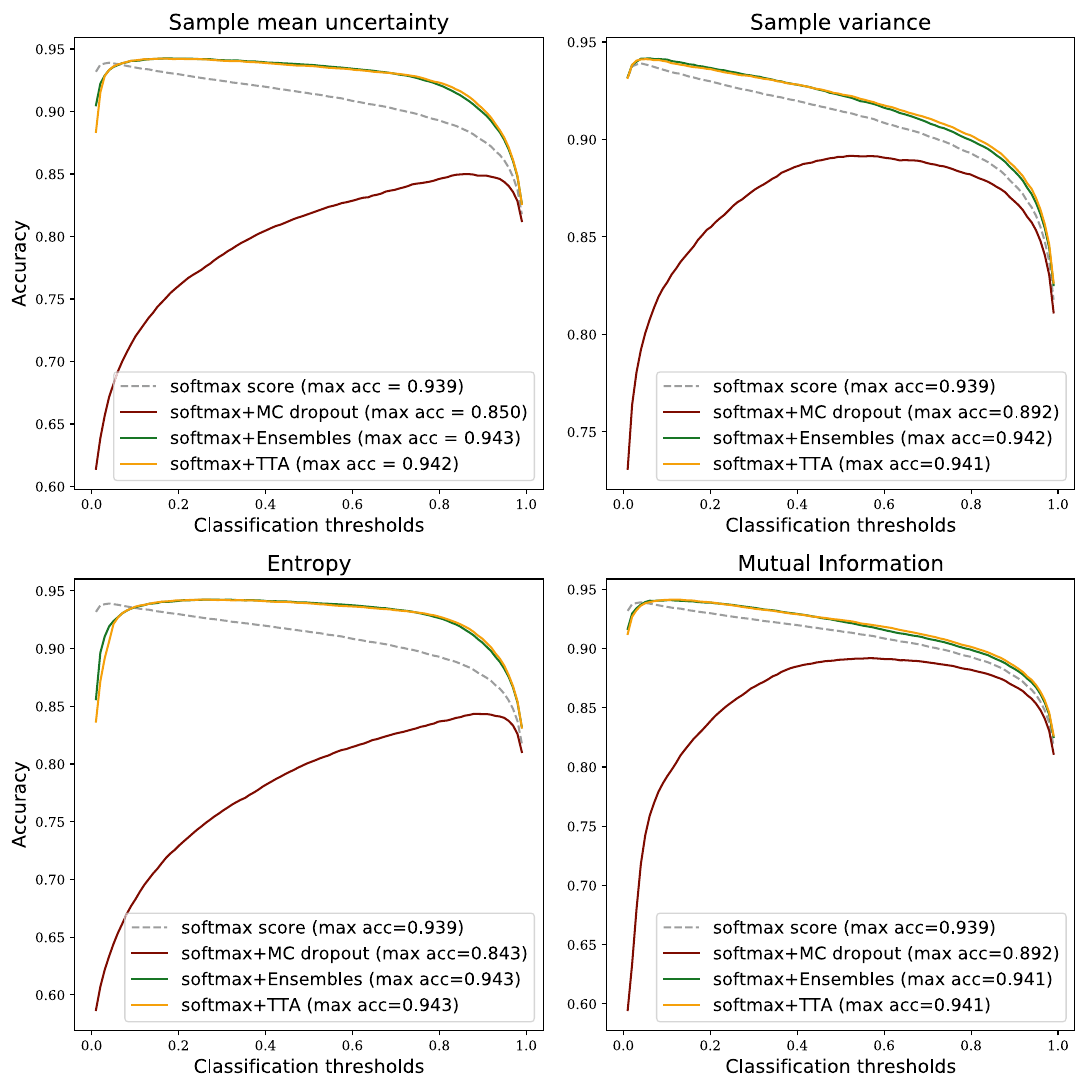
Figure 4. Prediction accuracy on Camelyon16 data when combining softmax tumour score from a single NN with uncertainty